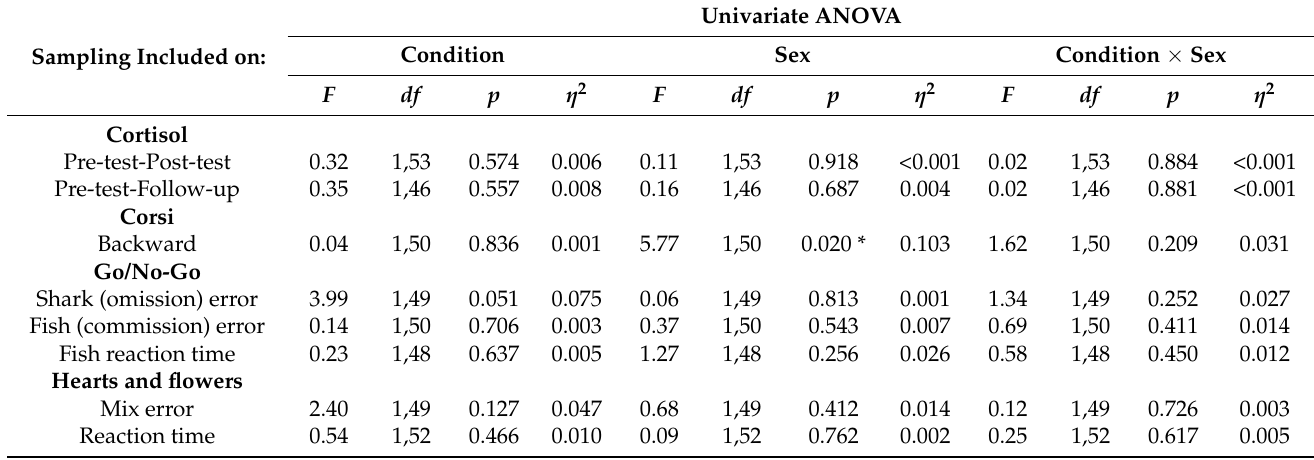
Table 3. Group (intervention vs. control) and sex differences at pre-test with respect to executive functioning skills and cortisol levels. Univariate ANOVA Condition Sex Condition × Sampling Included on: